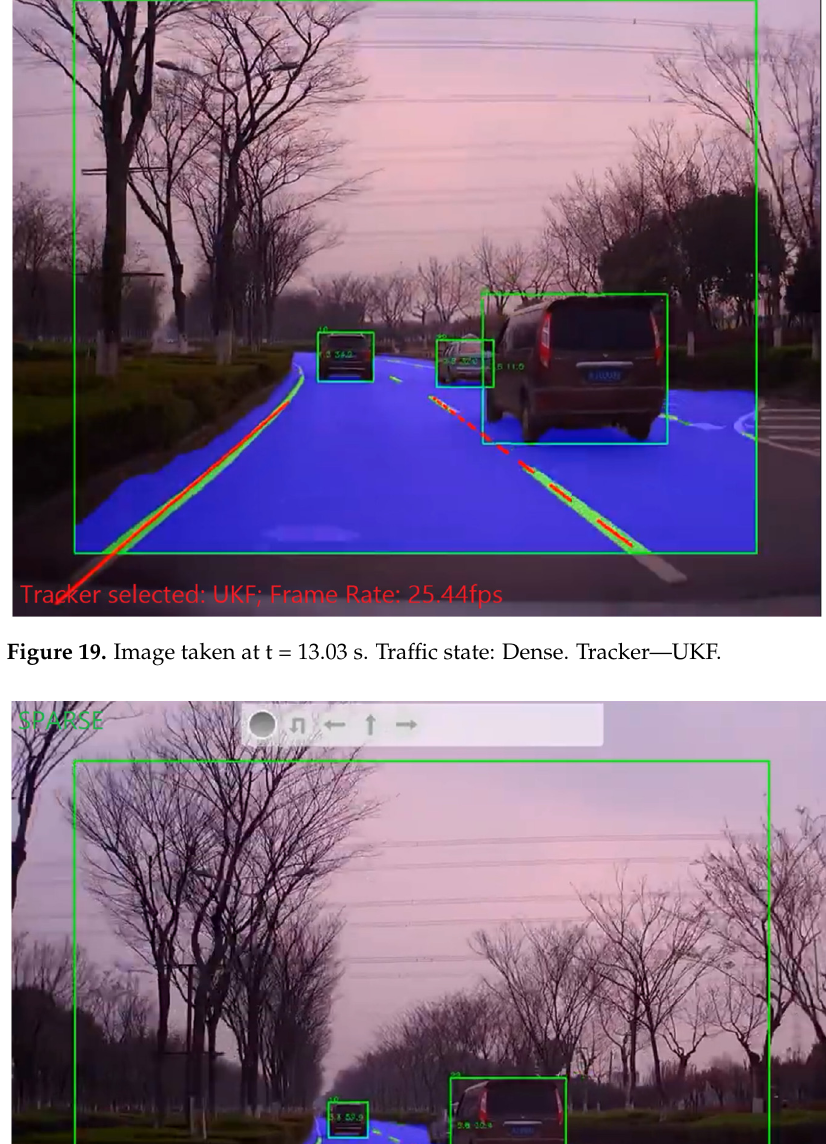
Figure 18. Image taken at t = 12.33 s. Traffic state: Dense. Tracker—UKF.